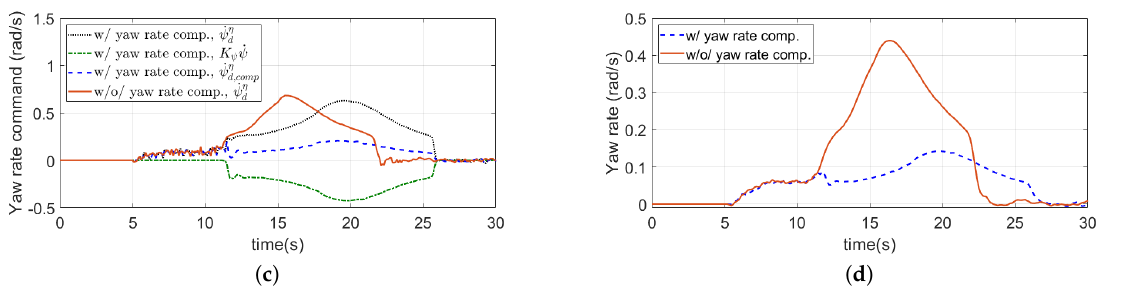
Figure 13. Simulation result of yaw rate effect compensation: ( a ) trajectories of the MAV; ( b ) time history of the sum of the EOF; ( c ) time history of the yaw rate command; and ( d ) time history of the yaw